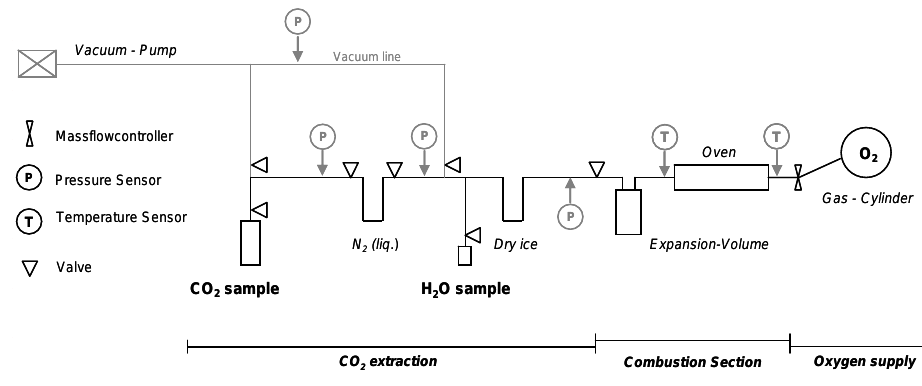
Fig. 1. Sketch of the technical set-up. For detailed description see